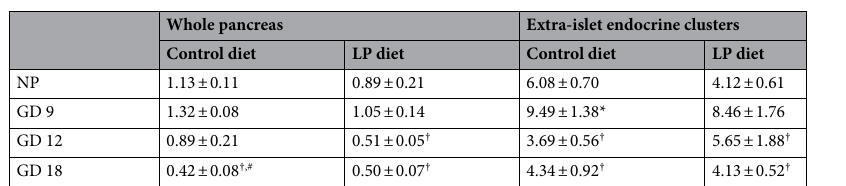
Table 2. Percentage of Ins + Glut2 LO cells relative to total insulin immunoreactive β-cells in histological sections of non-pregnant (NP) and pregnant mouse pancreas (GD 9–18) previously exposed in early life to control or low protein (LP) diet. Values show mean ± SEM (n = 4–6) for percentage of Ins + Glut2 LO cells compared to all insulin immunoreactive cells for entire pancreas sections and for the population of extra-islet endocrine clusters alone. *p < 0.05 vs, NP, † p < 0.05 vs. GD9, # p < 0.01 vs. NP, one way analysis of variance. Comparisons by two way analysis of variance between control and LP diet showed no significant differences between mean values for either whole pancreas or clusters.